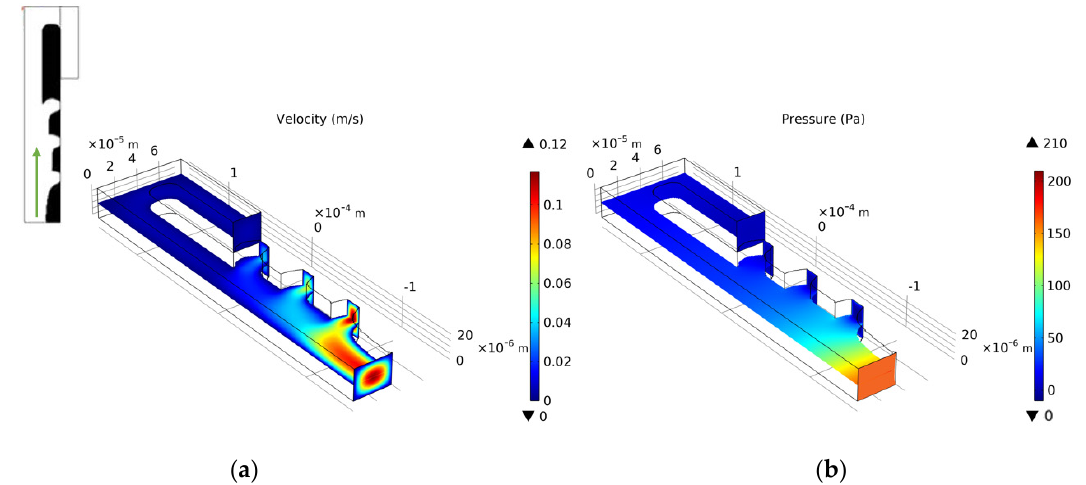
Figure 12. ( a ) The velocity field distribution and ( b ) pressure field distribution of 3D model without captured cell.